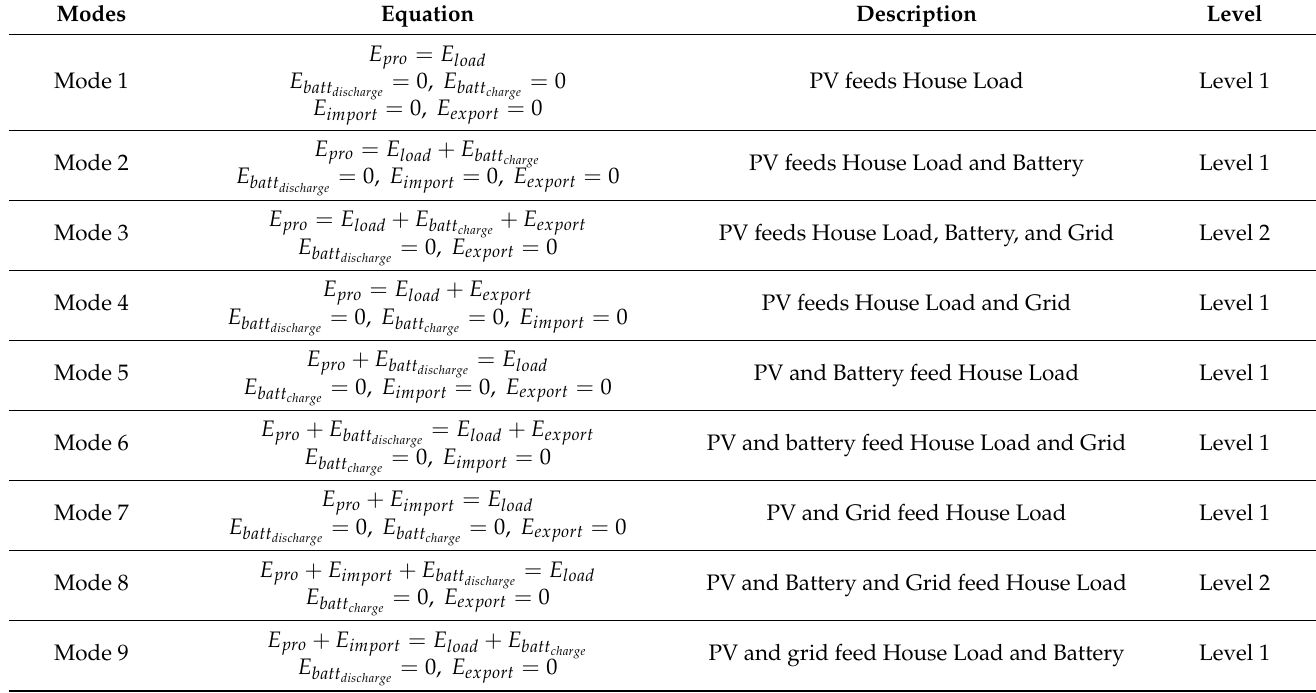
Table 1. Operation Modes of proposed energy management